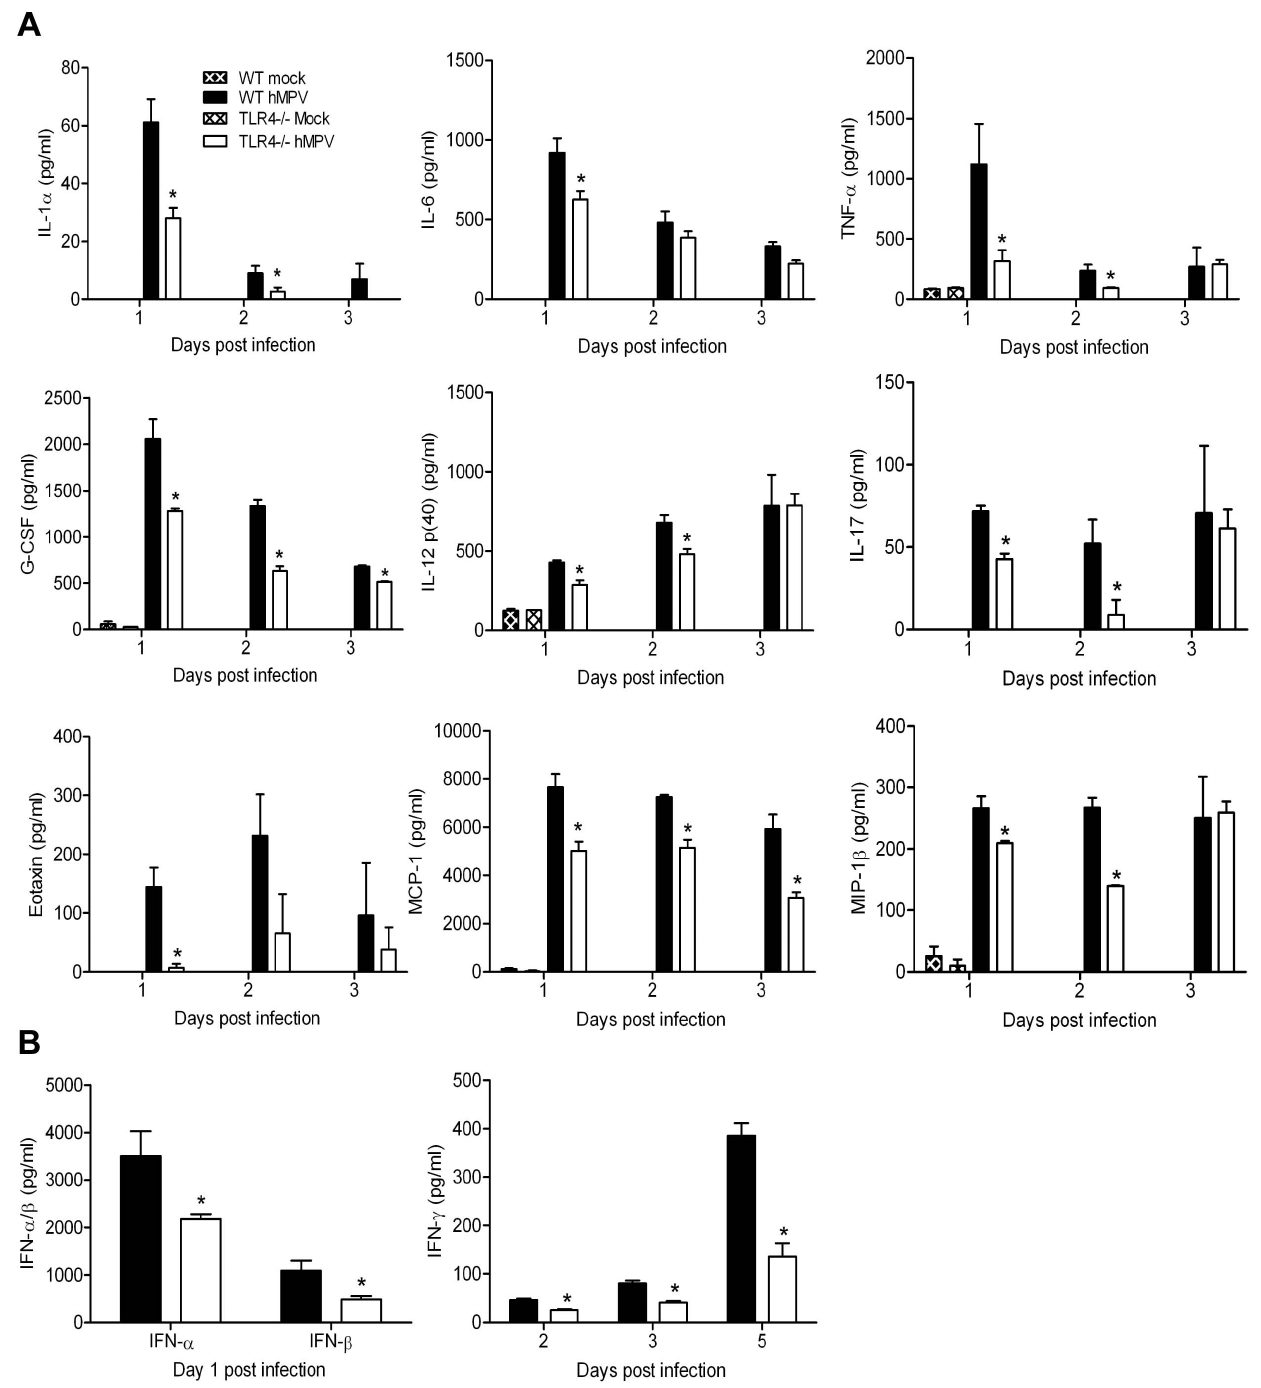
Figure 2. Expression of pro-inflammatory cytokine, chemokines and type I IFNs in response to hMPV infection of TLR4-deficient mice. TLR4 2 / 2 and WT mice were either infected with hMPV or mock infected, and sacrificed at days 1, 2, 3, 5, 7 p.i. to collect BAL fluid. Levels of IL- 1 a , IL-6, TNF- a , G-CSF, IL-12 p(40), IL-17, Eotaxin, MCP-1, MIP-1 b in BAL fluid were measured by Bio-Plex ( A ). Levels of IFN- a / b (left panel) were measured by ELISA on day 1 p.i., while IFN- c (right panel) was measured by Bio-Plex at various days p.i. ( B ). Data are expressed as mean 6 SEM of four to six animals/group and represents one of two independent experiments. * P , 0.05 when comparing hMPV infected TLR4 2 / 2 mice to infected WT